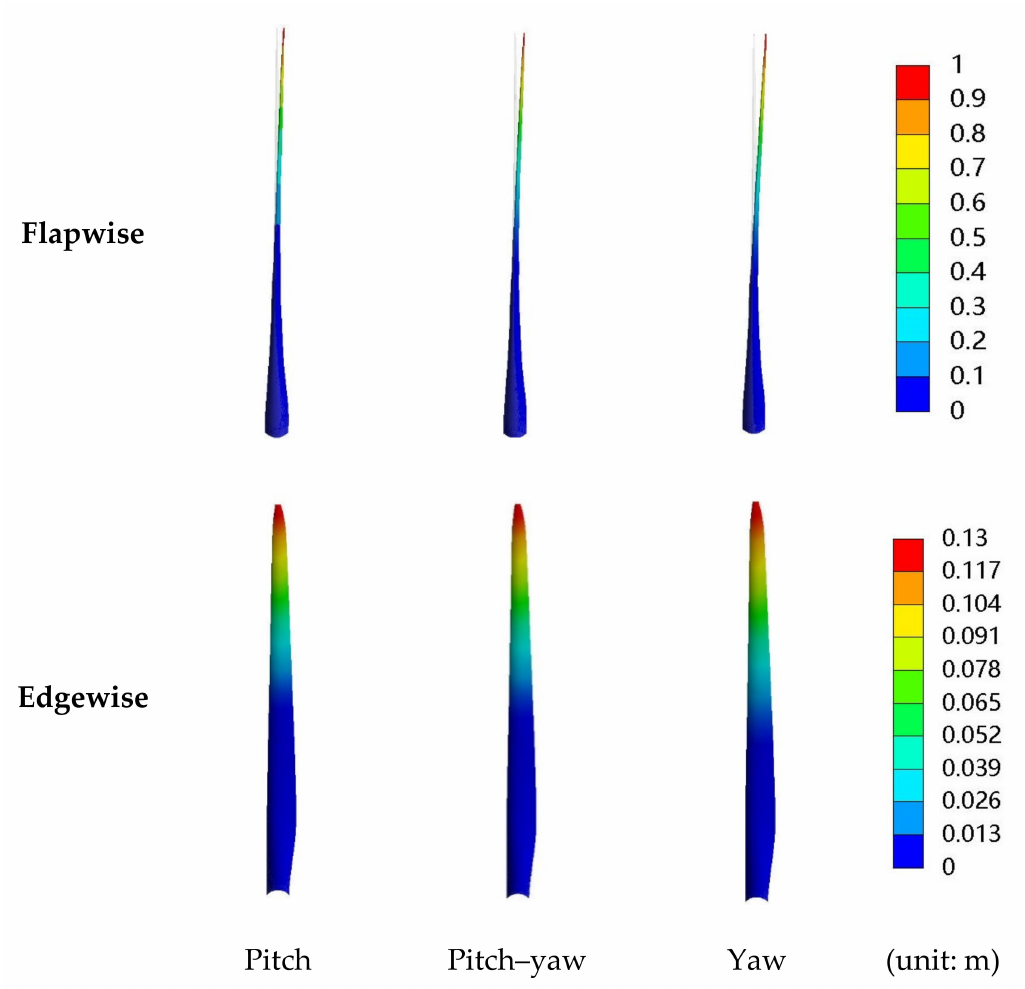
Figure 23. Blade deflection under the backward